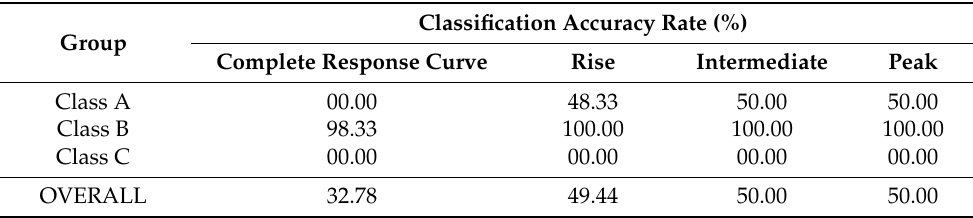
Table 9. Classification accuracy rate results with LDA application and validation